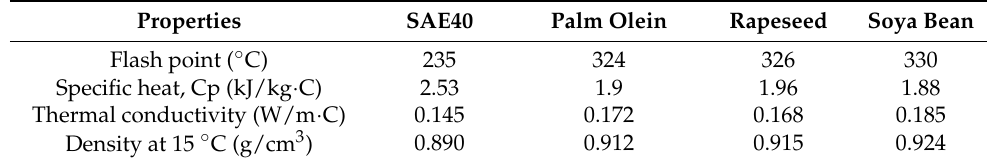
Table 2. Physical properties of oil samples [28].